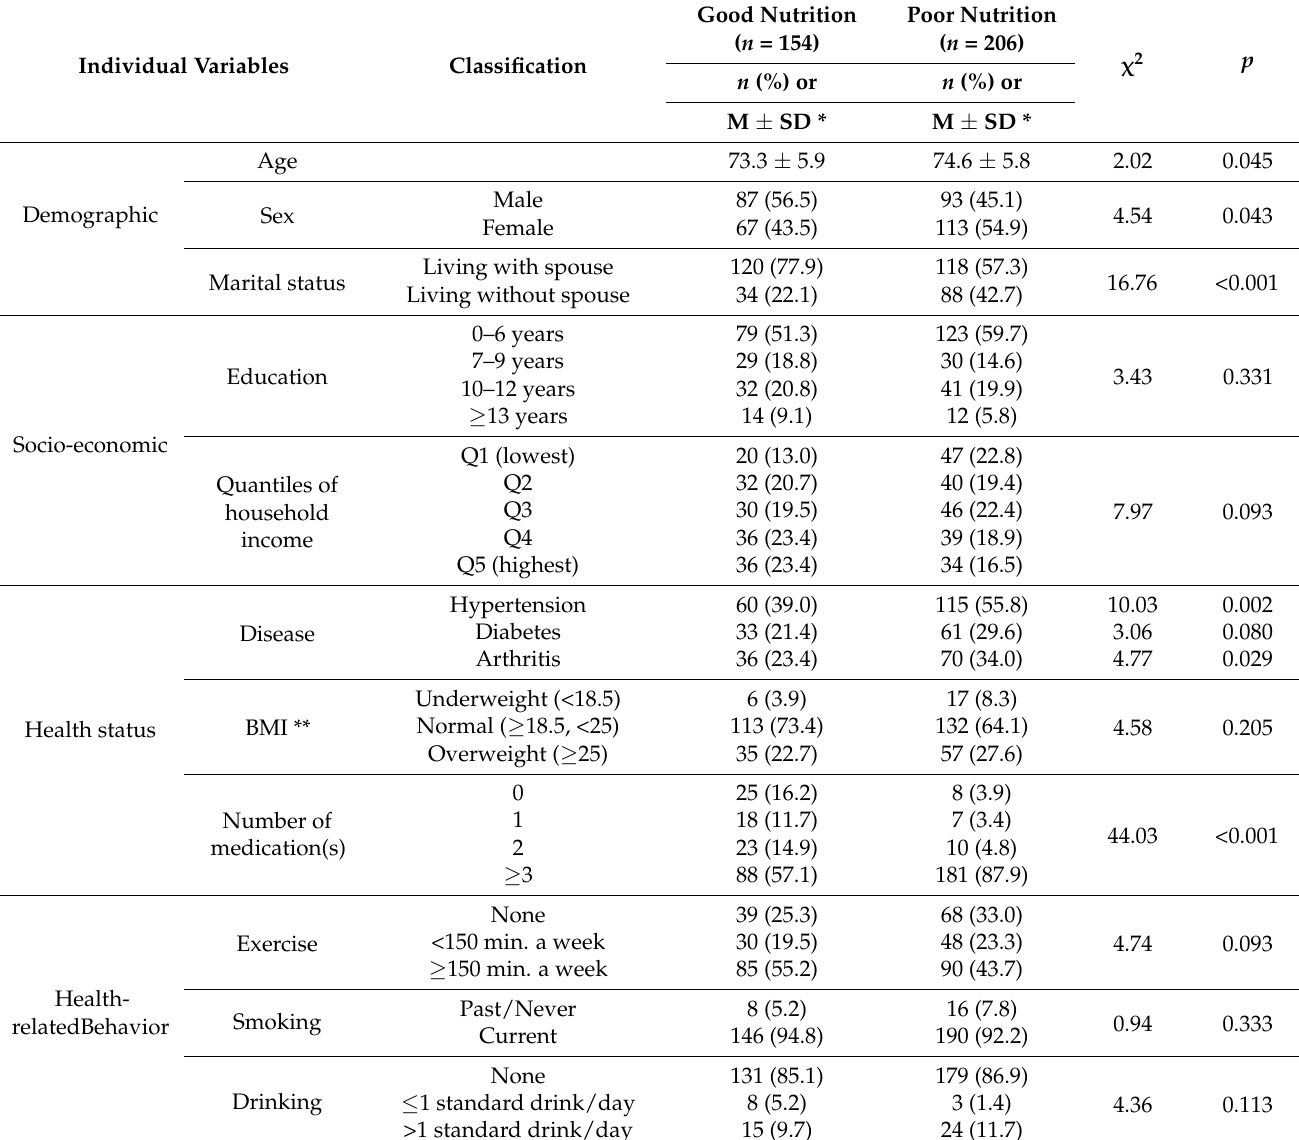
Table 1. Differences in individual variables between good and poor nutrition ( n =